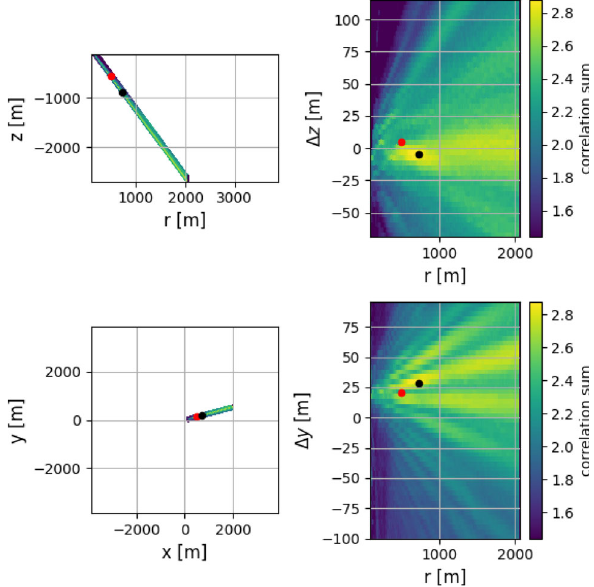
Fig. 6 Vertex reconstruction. Results are projected into the horizontal distance vs. depth (top) or east vs. west plane (bottom), with the colors showing the maximum correlation sums over all azimuths and depths, respectively. The left side shows results in coordinates relative to the station position. Zones that are outside the search volume are in white. The right shows coordinates relative to the vertex search region. The red dots mark the true vertex position, the black dots the position with the largest correlation sum